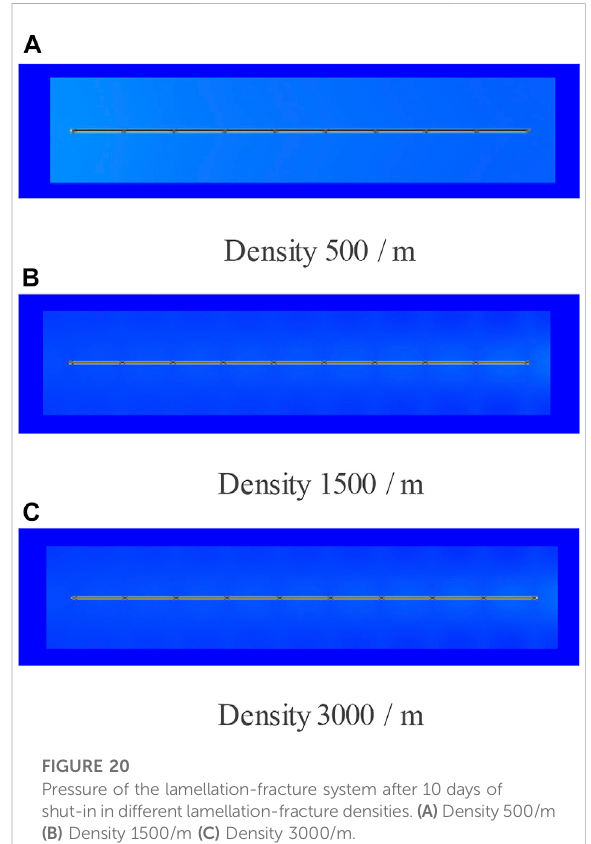
FIGURE 20 Pressure of the lamellation-fracture system after 10 days of